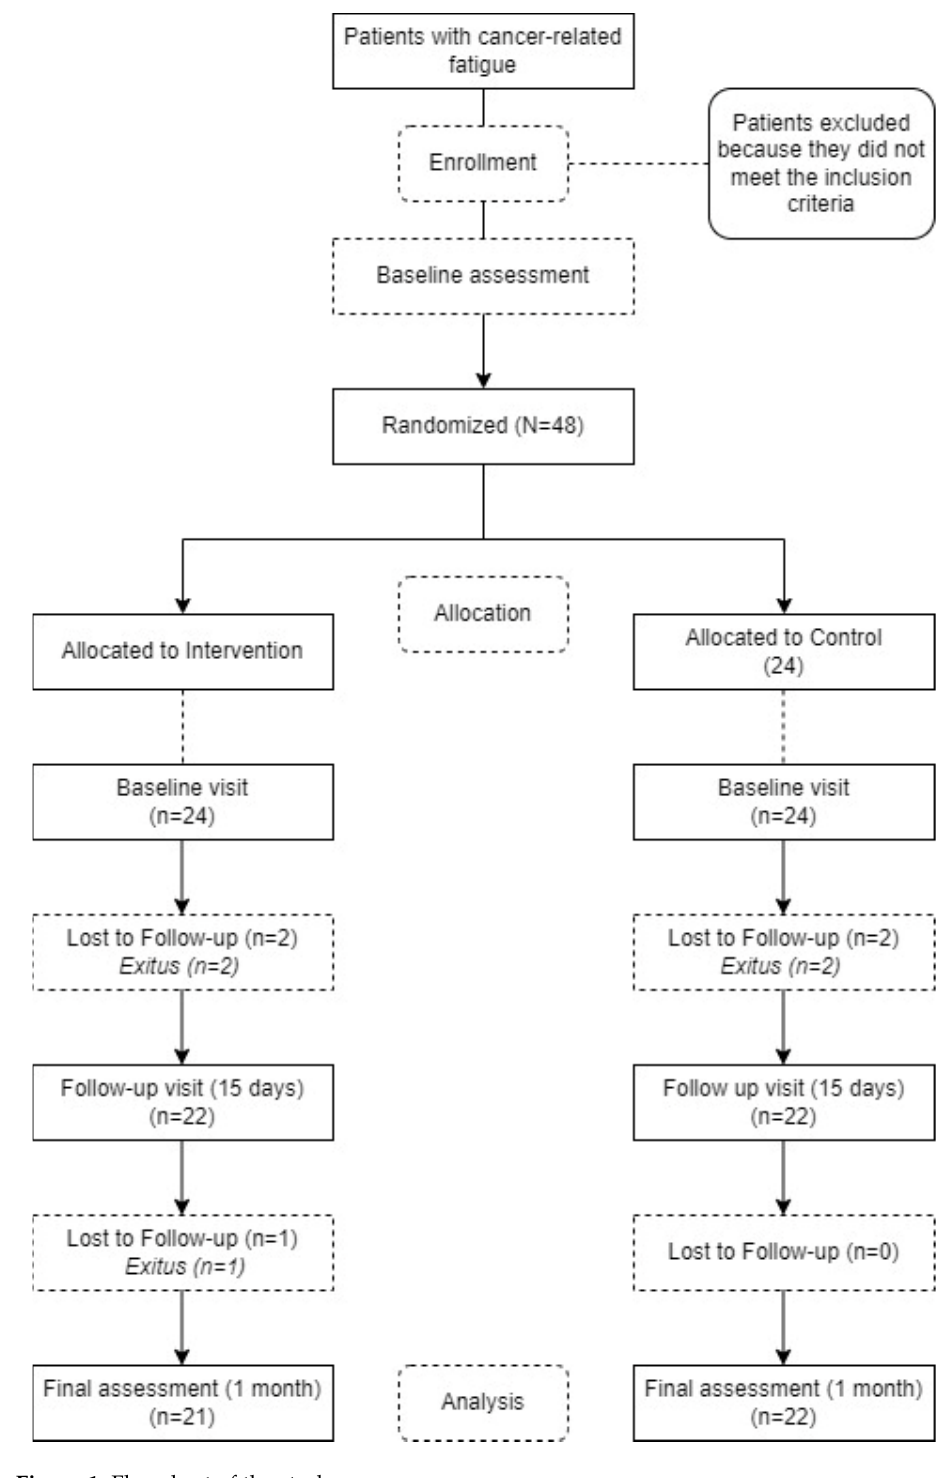
Figure 1. Flowchart of the study.